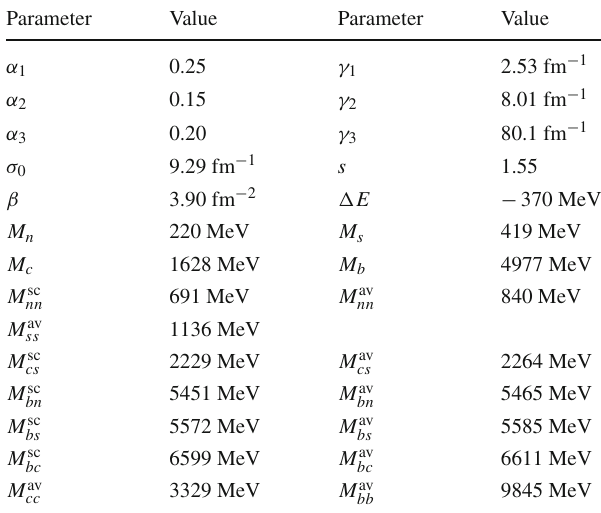
Table 1 Parameters specifying the Hamiltonian in Eq. (1). Here: n = u or d ; and the superscripts “sc” and “av” indicate scalar and axial-vector diquarks, respectively. M n , s , c , b are the valence quark masses Parameter